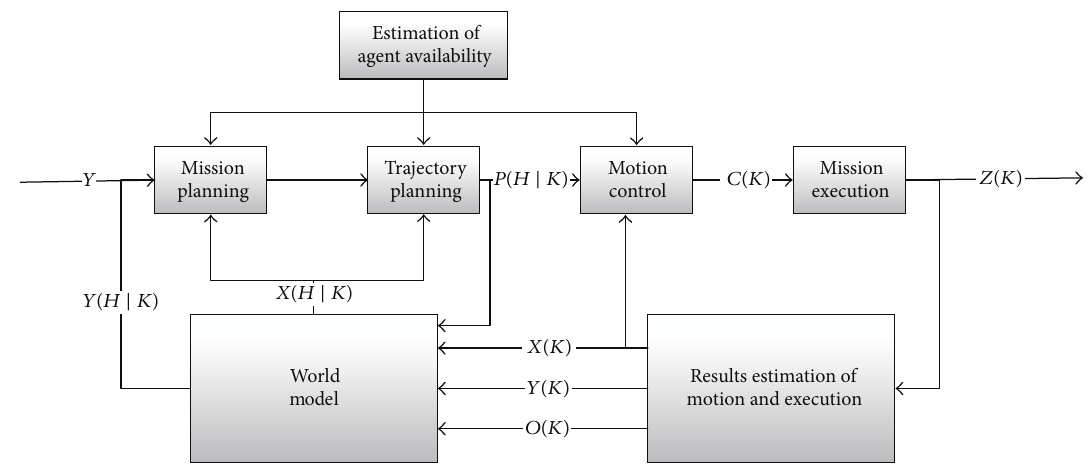
Figure 10: Control system of the mission